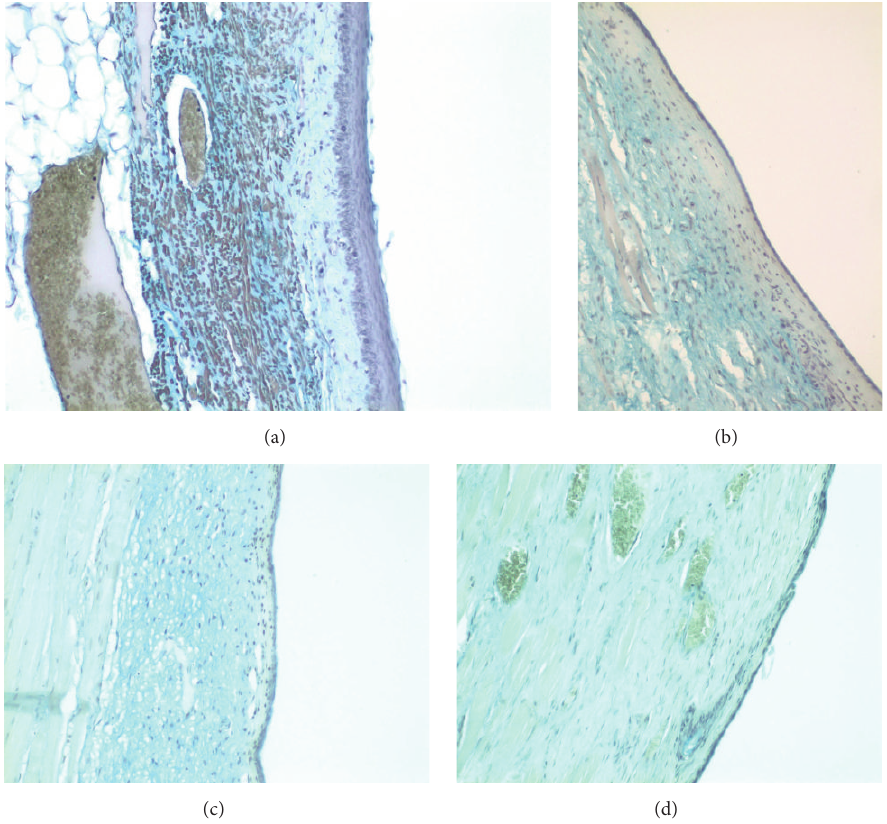
Figure 12: (a) Normal vocal fold. (b) Scarred vocal fold. (c) Injection of ADSC. (d) Injection of hyaluronan.